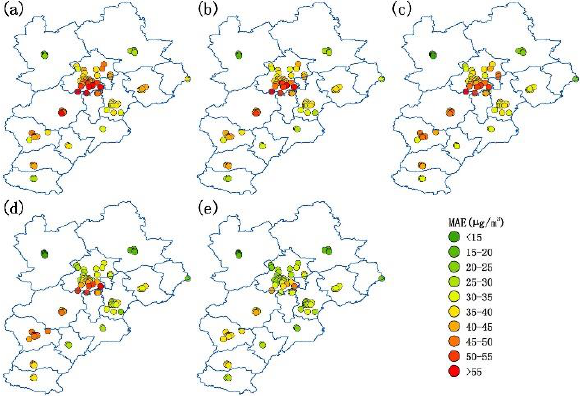
Figure 4 . Spatial distribution of MAE of the STAR model at different monitoring sites using different simulation functions.